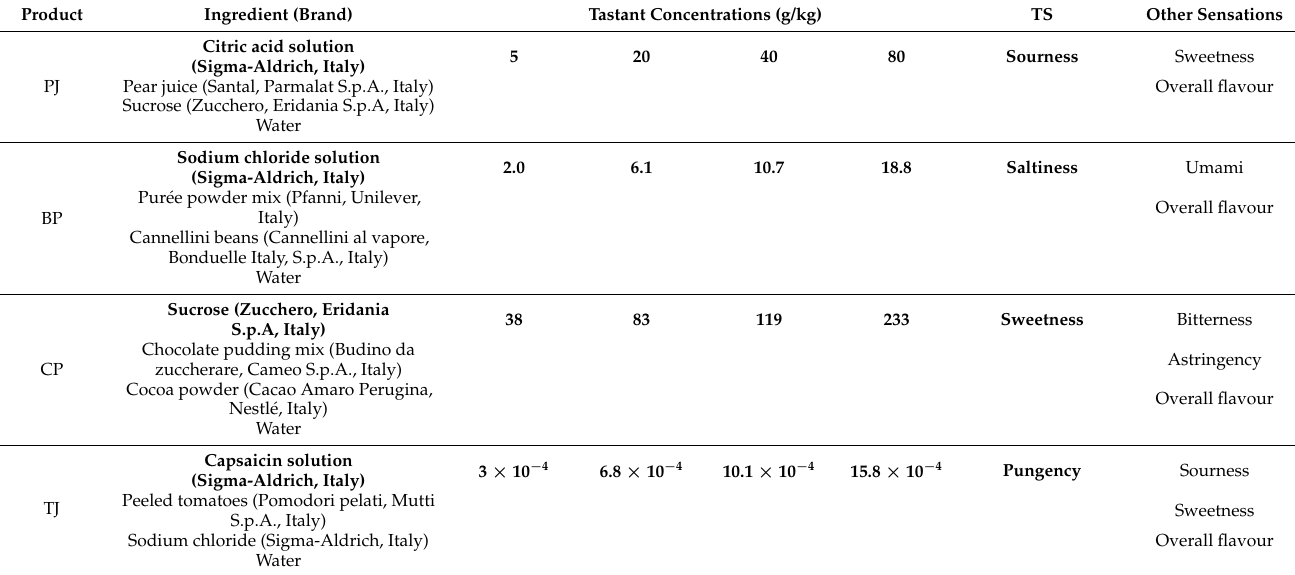
Table 1. Food models: food product (PJ = Pear Juice, BP = Bean Pur é e, CP = Chocolate Pudding, and TJ = Tomato Juice), ingredients, ingredient brand, tastant concentration at each level, target, and other measured sensations are reported (tastants responsible for the target sensation are written in